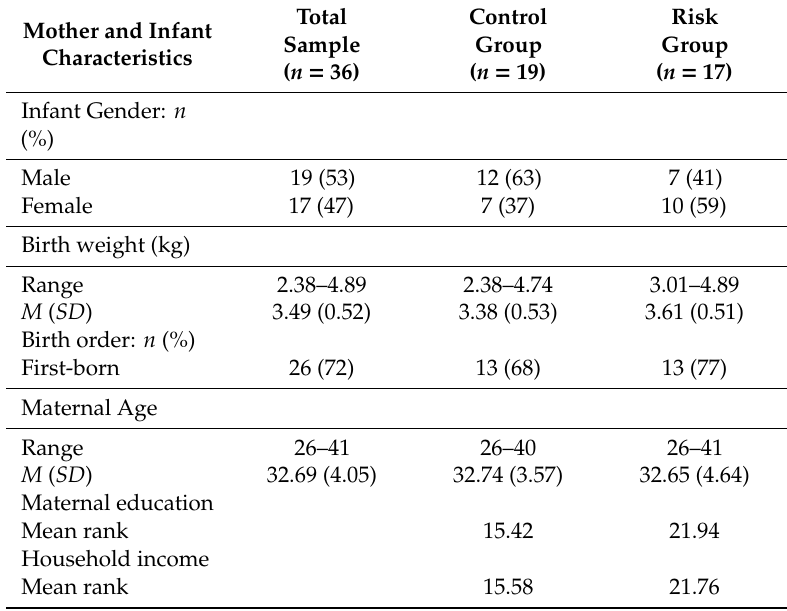
Table 1. Descriptive and inferential statistics for participants’ demographic